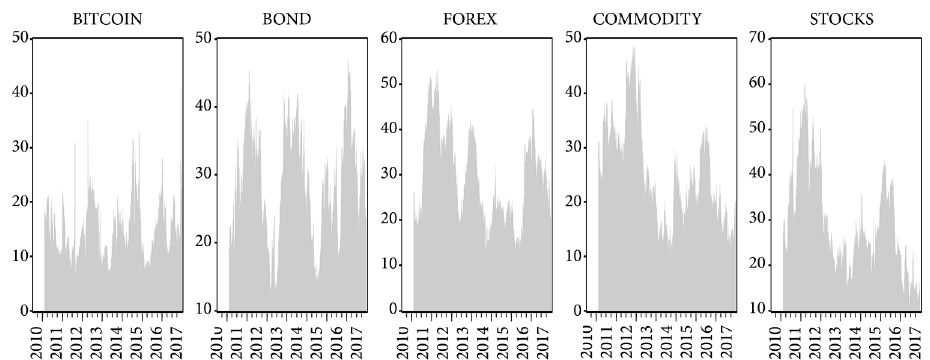
Figure 3. Directional volatility spillover to U.S. bitcoin and financial markets